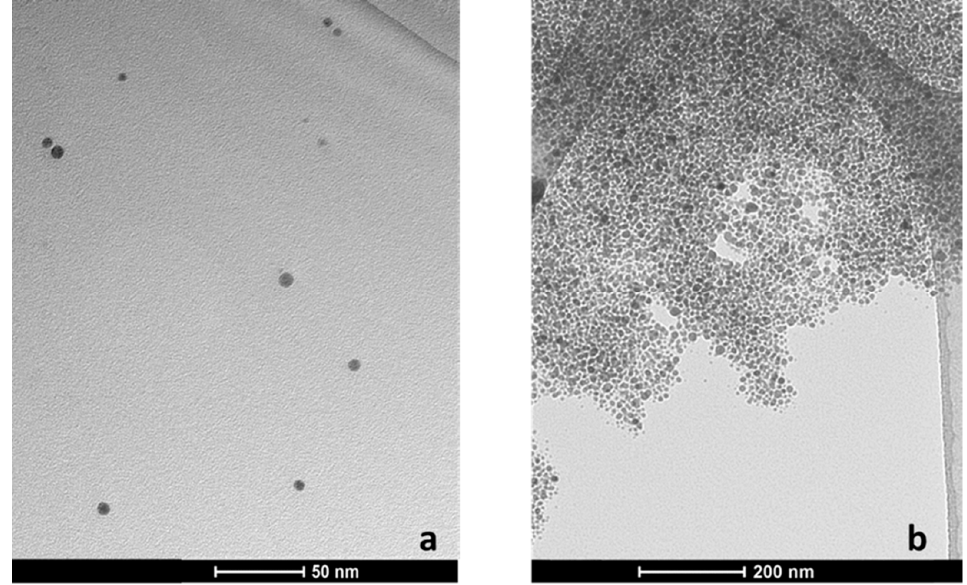
Figure 5. Transmission electron microscope images of silver nanoparticles solutions; ( a ) silver nanoparticles coated with “non-aggregating” free light chains (10 mg/L (500 nM)), stable, with a protein corona (variant 1); ( b ) nanoparticle aggregates—silver nanoparticles coated with aggregation-inducing free light chains (10 mg/L (500 nM)) (variant 2).